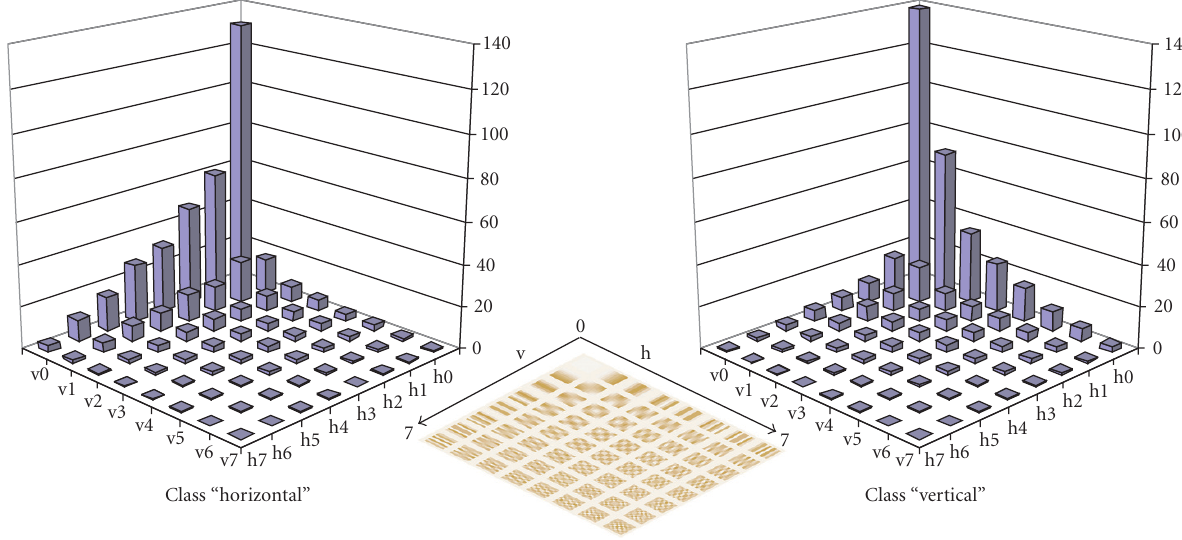
Figure 14: Statistics of the average absolute values of the DCT coe ffi cients taken after quantization with qscale = 1. Here, the “table tennis” sequence was coded with I-frames only. The left (right) graph shows the statistic for blocks classified as having horizontal (vertical) edges.